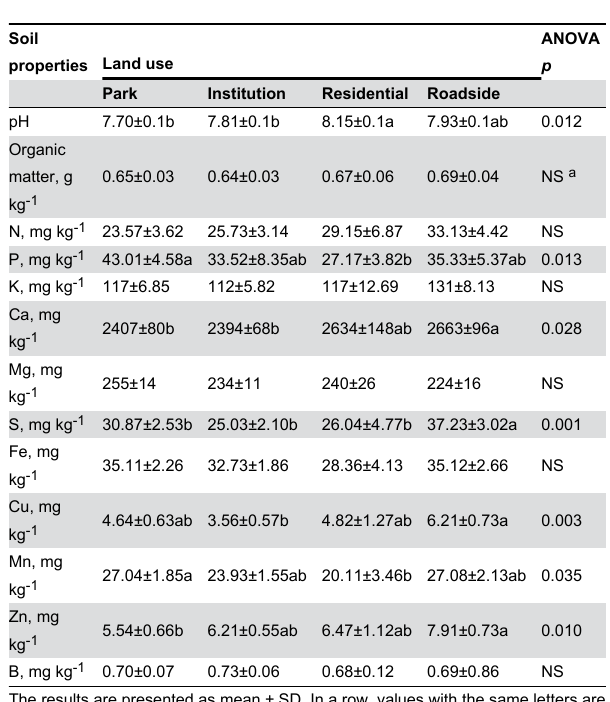
Table 5. Mean surface soil properties (0–20 cm) for land use types (park, n =87; institution, n =131; residential, n =92; roadside, n =95).